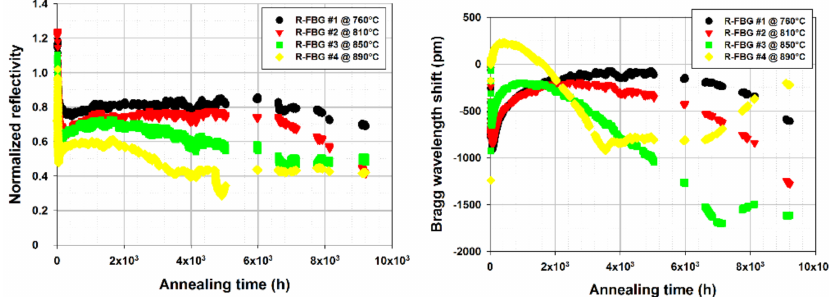
Figure 7. Evolution of the Reflectivities ( right ) and Bragg Wavelength Shifts ( left ) of four regenerated FBGs over a one year-long thermal ageing experiment up to 890 ◦ C, published by the authors in